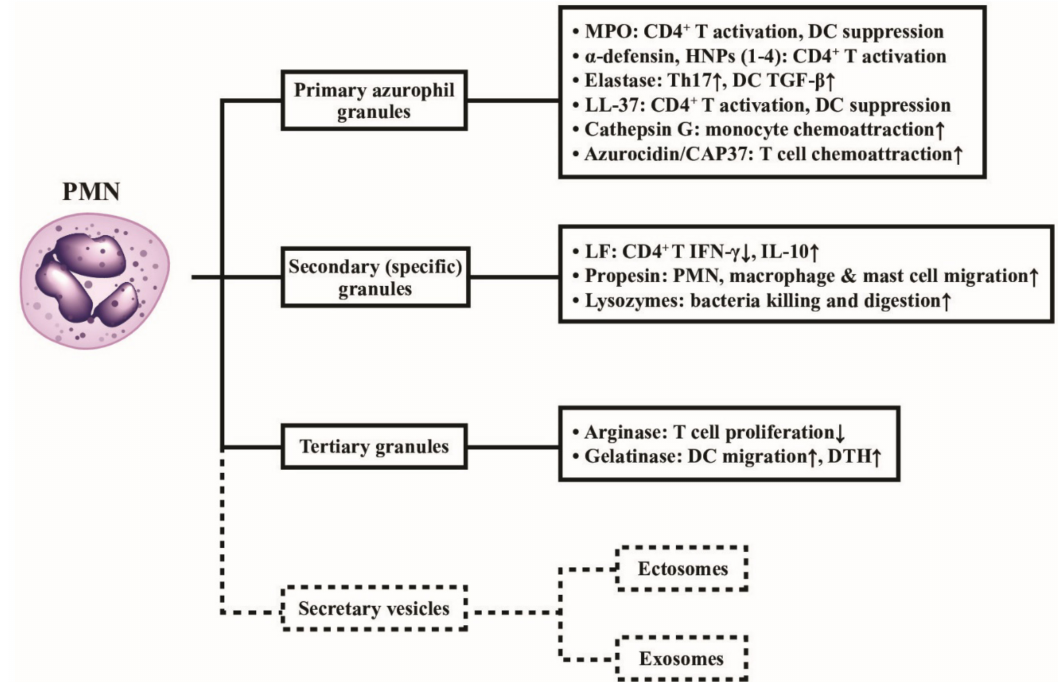
Figure 3. Classification of neutrophil granules and their immunological functions. Different granule proteins included in the primary, secondary, and tertiary granules are summarized in brackets. The vesicles extruded from PMNs are simply divided into ectosomes and exosomes. The formation, composition, and biological/pathobiological functions of the secretary vesicles are not shown in the figure and are instead described in detail in Figure 4. MPO: myeloperoxidase; HNP: human neutrophil peptide; IL: interleukin; IFN: interferon; DC: dendritic cell; DTH: delayed-type hypersensitivity; LF: lactoferrin;